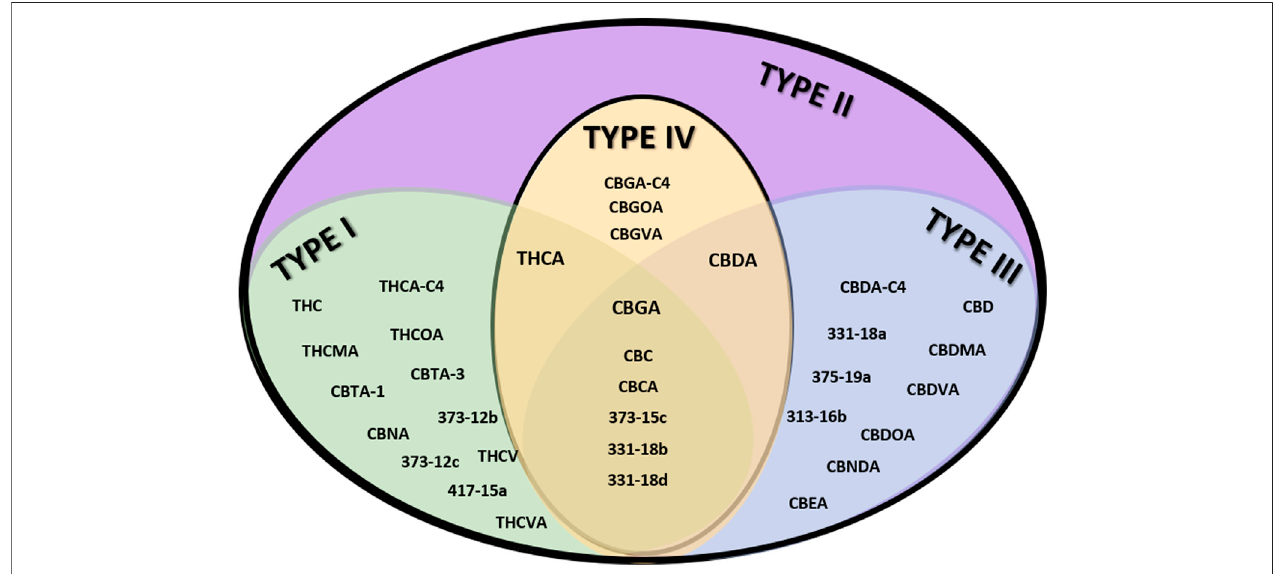
FIGURE3| Venndiagramofthedistributionofparticularphytocannabinoidstospeci fi cchemovars.Examplesofuniquephytocannabinoidsperchemovartypeare shown in the appropriate subgroup.